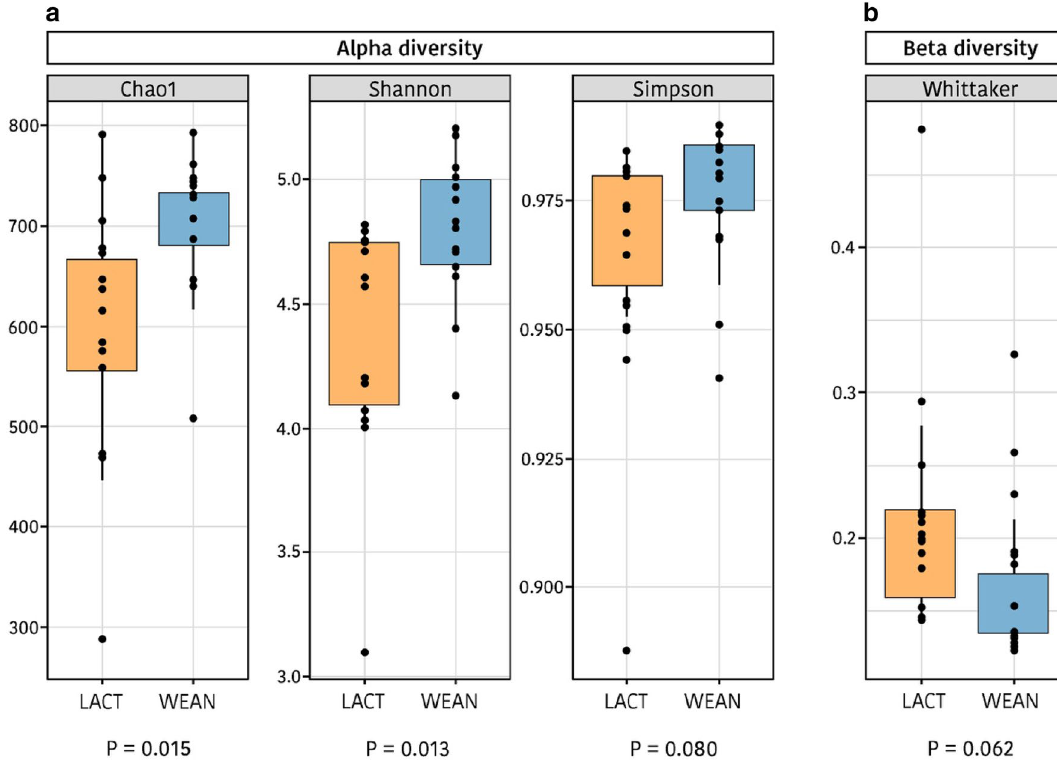
Figure 1. Box plot of the alpha ( a ) and beta ( b ) diversity during lactation (LACT) and after weaning (WEAN) based on the calculation of different indices: Chao1, Shannon and Simpson for alpha diversity, and Whittaker for